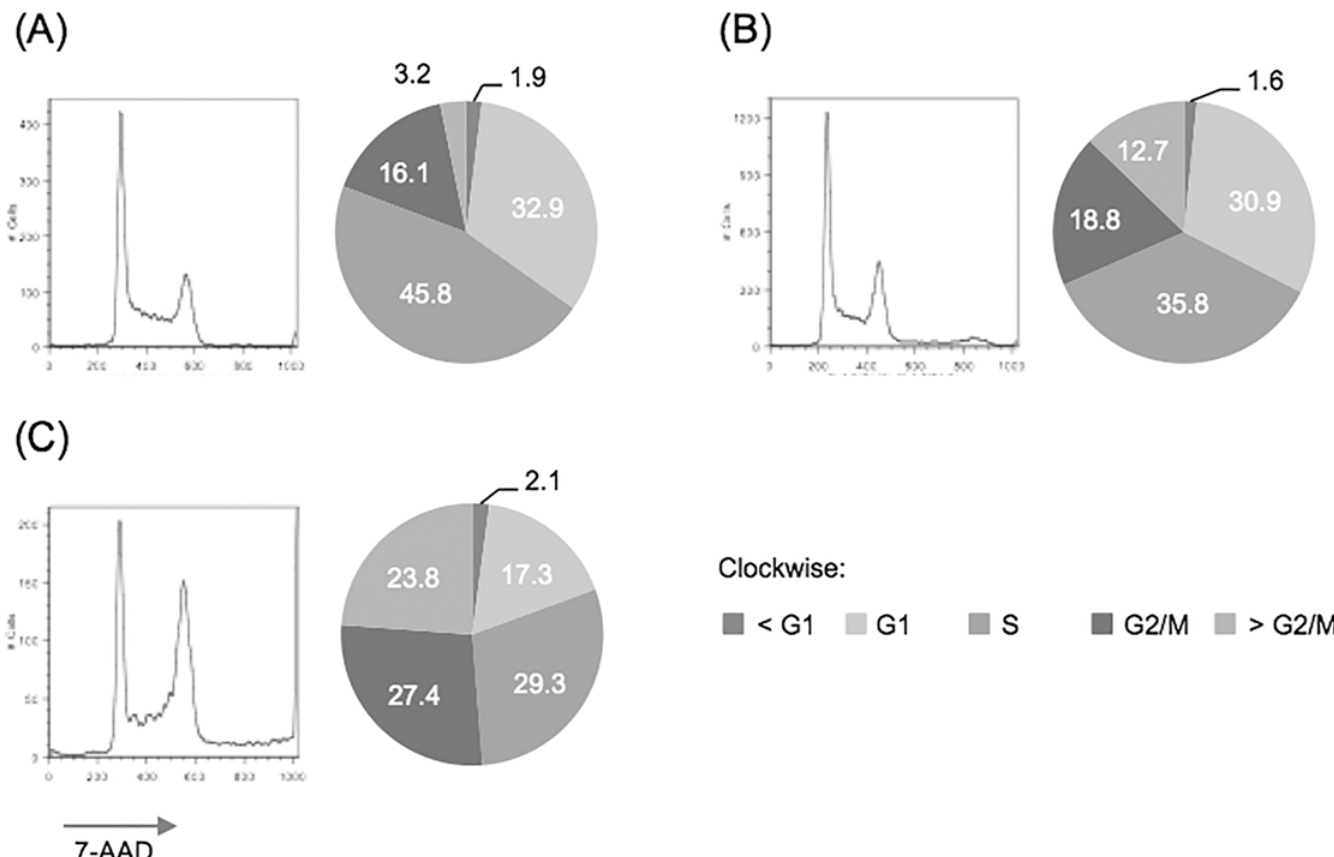
Fig 6. Cell cycle analysis of GFP-sorted, transfected cells. GFP-positive NALM6 cells at 48 hours post-transfection were fixed with ethanol before 7-AAD staining. DNA content (7-AAD intensity) was measured using a flow cytometer; (A) untransfected, (B) pEGFP-C1, or (C) pEGFP-TES, ( left : cell cycle profile histograms) and analysed using the Watson Pragmatic Cell Cycle module (FlowJo) and proportion of cells in each cell cycle phase calculated ( right : pie charts).